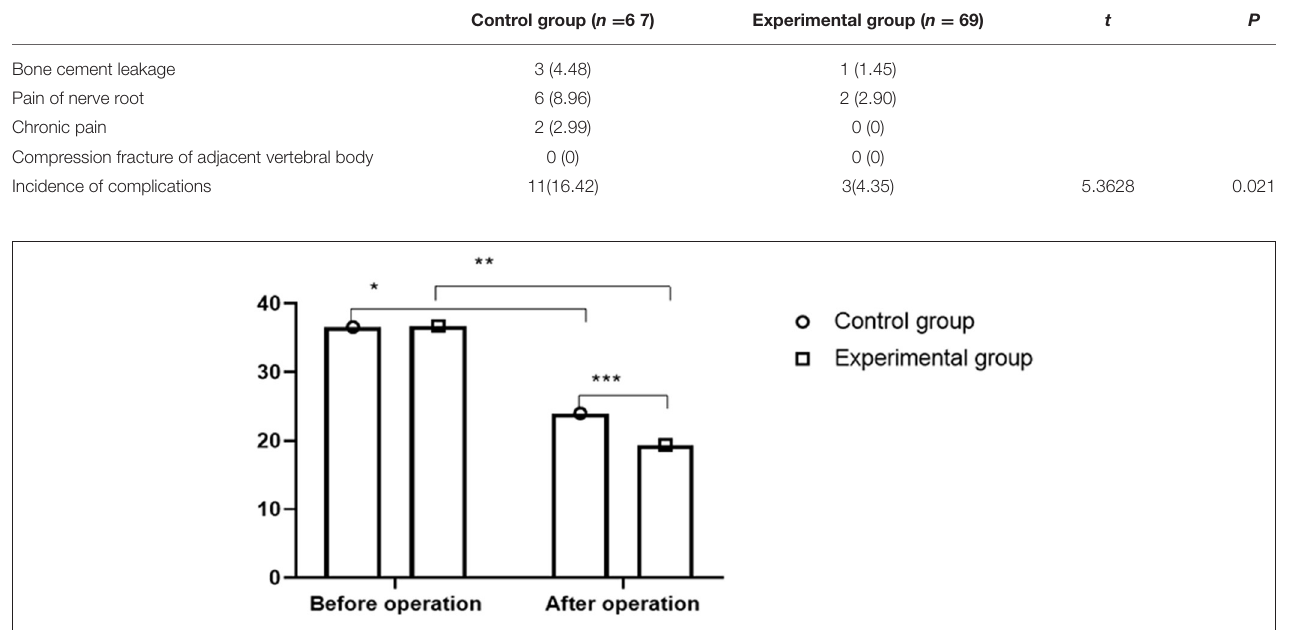
TABLE 3 | Comparison of the incidence of postoperative complications between the two groups [ n (%)].